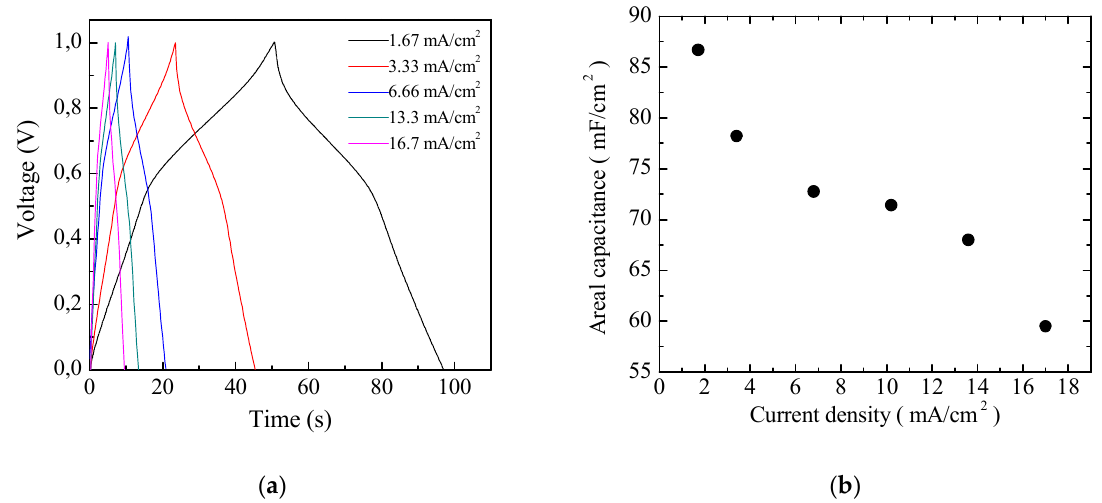
Figure 11. ( a ) Voltage versus time measured in charging–discharging cycles at a constant density on the same Au/PPy:DBSA/Nafion:LiPs/PPy:DBSA/Au cell that Figures 9 and 10 refers to; ( b ) areal capacitance estimated from the charge – dicharge curves of ( a ) as a function of the current density.